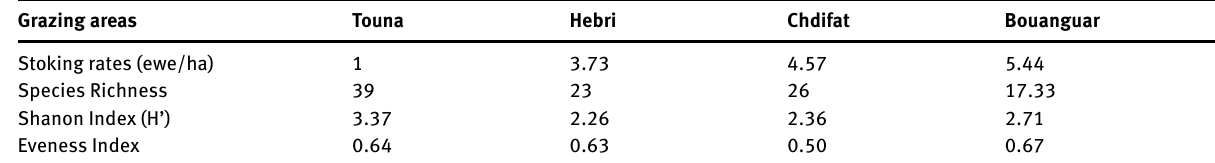
Table 2: Species Richness, diversity index and evenness index in grazing areas stocked differently in the Middle Atlas Grazing areas